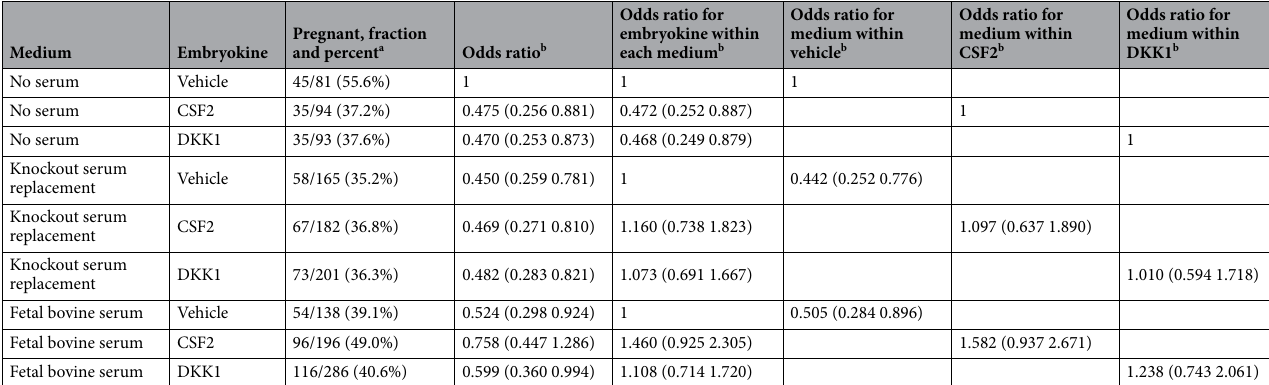
Table 1. Effect of culture medium and embryokine treatment of embryos on pregnancy outcome at day 30 of gestation. Abbreviations are as follow: BSA bovine serum albumin, CSF2 colony stimulating factor 2, DKK1 dickopf WNT signaling pathway inhibitor-1. a Pregnancy rate was affected by the interaction between medium and embryokine (P = 0.042) and by the contrast comparing serum replacement (SR) vs fetal bovine serum (FBS) (P = 0.056) and the interaction between effects of BSA vs SR + FBS and CSF2 (P = 0.004) and DKK1 (P = 0.015). b Odds ratios were calculated after adjustment for farm, sire and the interaction of sire with treatment.